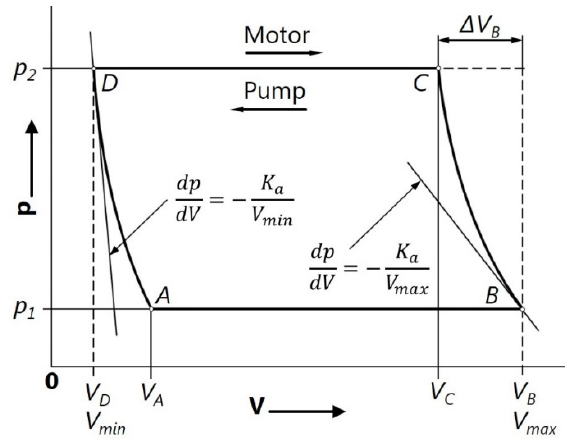
Figure 2. The schema of a displacement chamber.